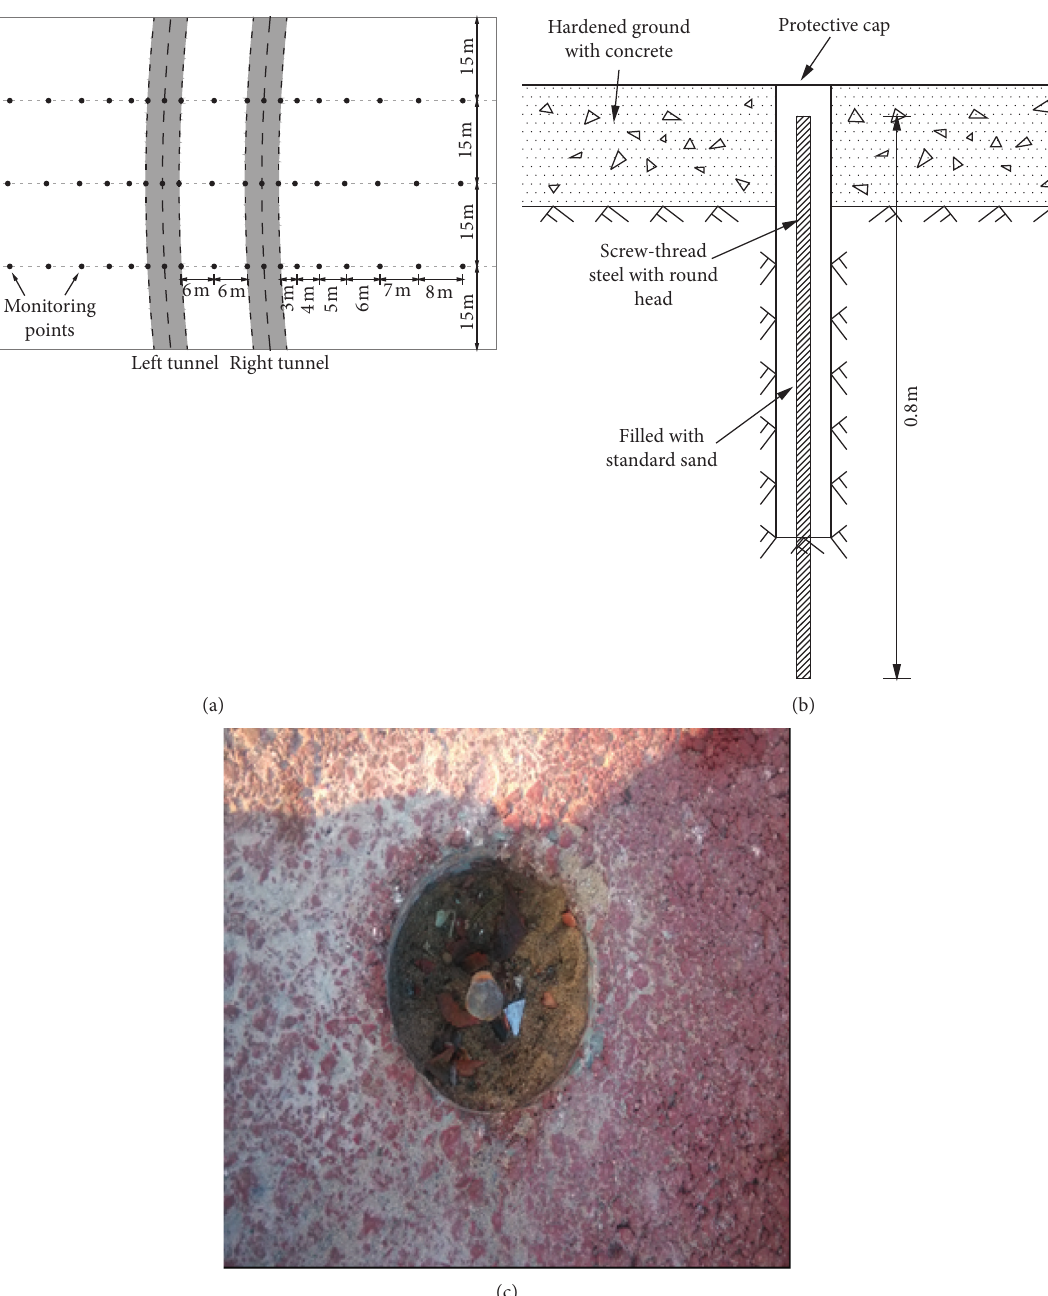
Figure 3: Schematic diagrams of ground surface settlement monitoring points: (a) distribution, (b) marker components, and (c) marker